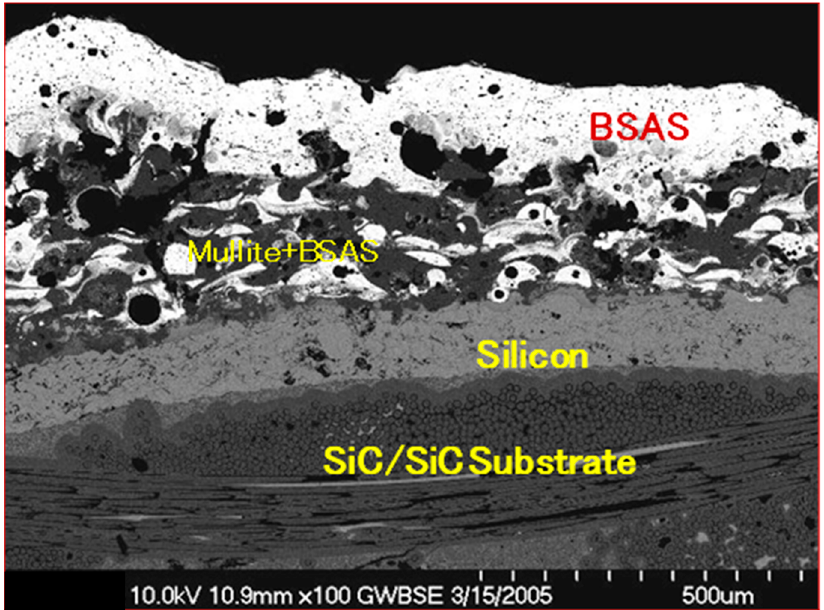
Figure 1. SEM micrograph of a typical cross-section of a plasma-sprayed environmental barrier coating (EBC) on a melted infiltration (MI) SiC/SiC substrate showing the microstructure, composition, and thickness of EBC sublayers.